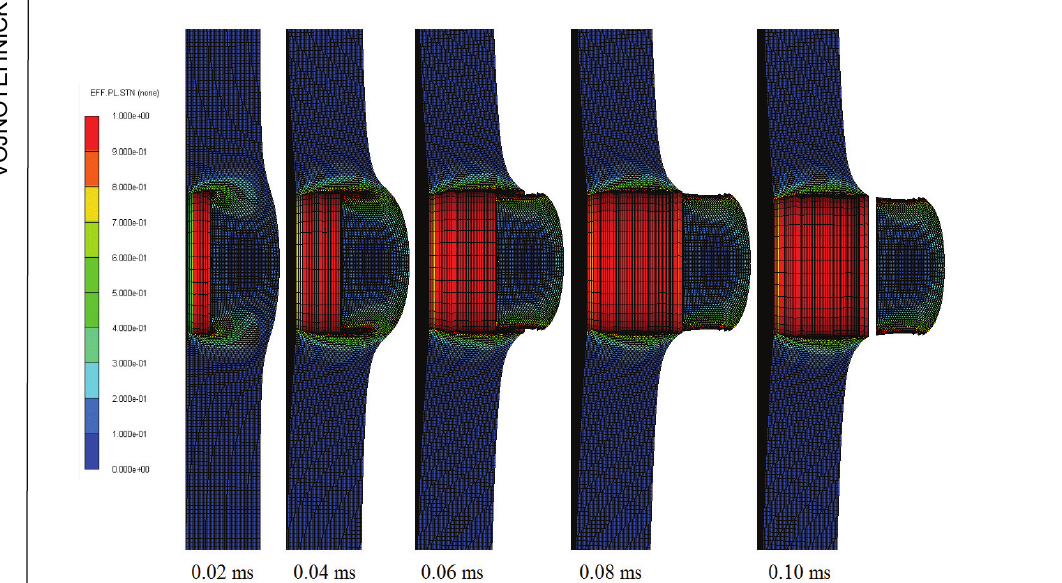
Рис . 18 – Перфорация стальной плиты тупоконечным снарядом (FEM метод ) Слика 18 – Перфорација челичне плоче тупим пројектилом ( ФЕМ метод